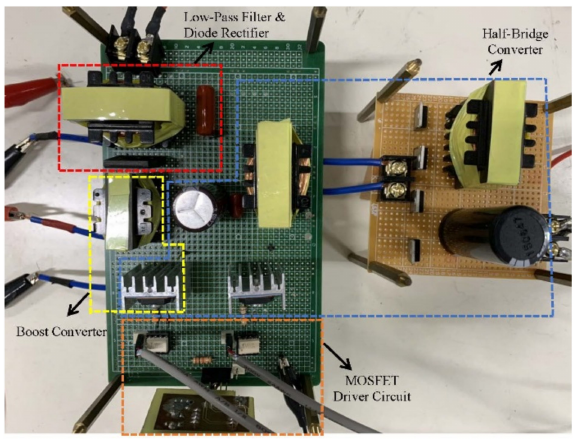
Figure 12. Prototype LED